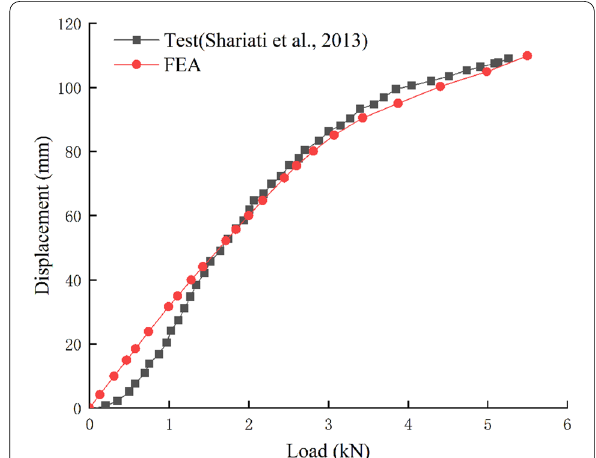
Fig. 17 Comparison of FEA analysis results and test results.